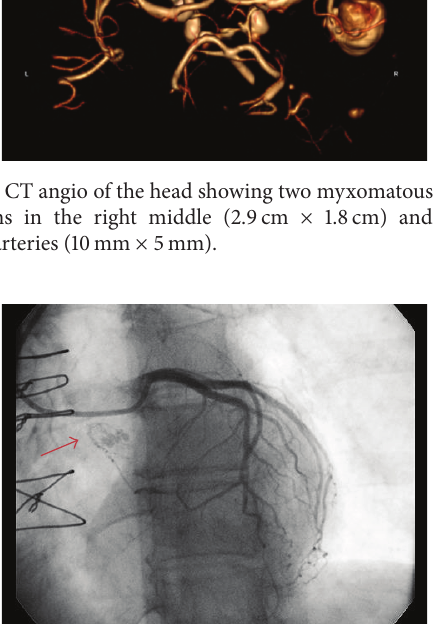
Figure 2: Cardiac catheterization showing normal coronaries and a tumor